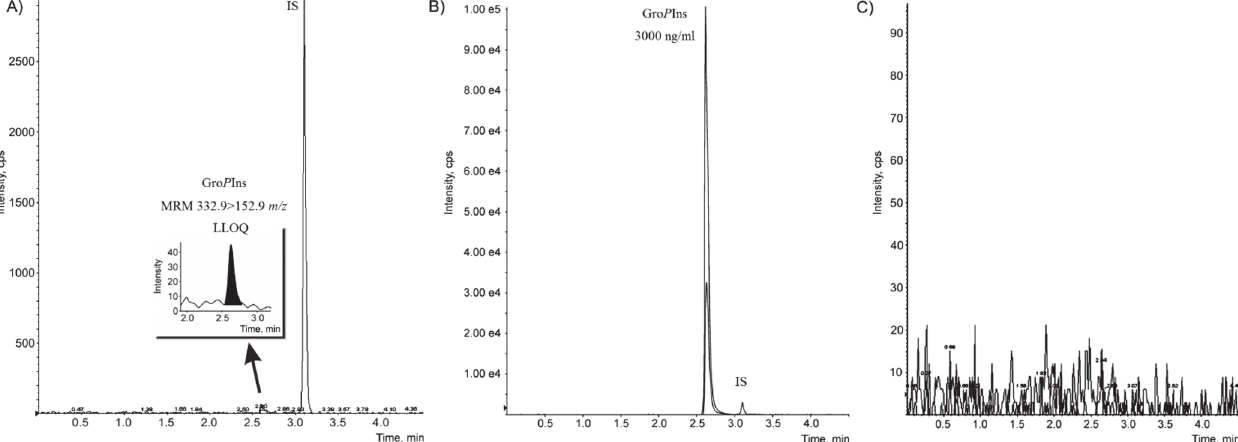
Fig 2. Representative LC-MRM chromatograms. (A) LOQ (3 ng/ml) of Gro P Ins in water. (B) Gro P Ins at the highest standard concentration (3,000 ng/ml) in water. (C) Blank sample after injection of the highest concentration of Gro P Ins (3,000 ng/ml).